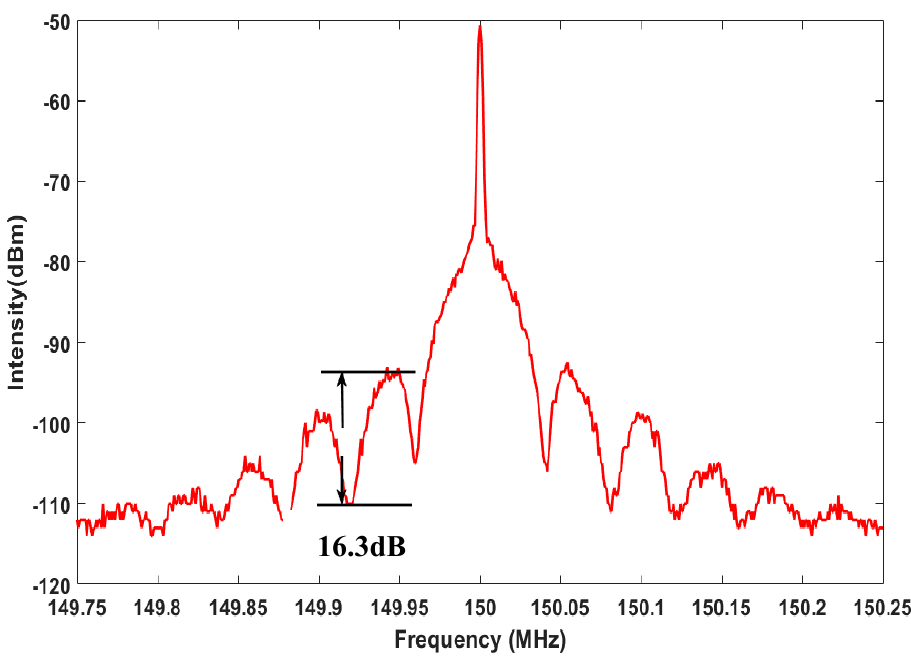
Figure 7. Actual recorded power spectrum of a 3 km delay length.